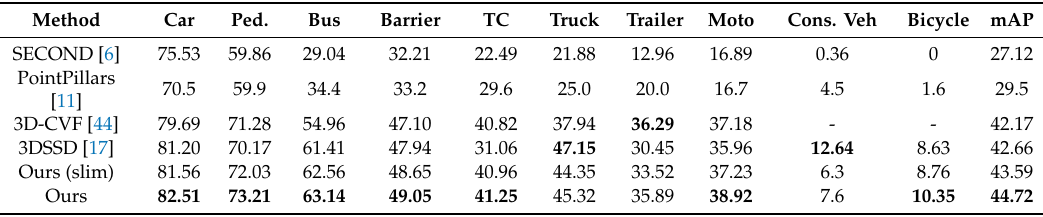
Table A1. Comparison of the 3D object detection performance of KDA3D with state-of-the-art 3D object detectors: Average Precision of 3D boxes on nuScenes’s val